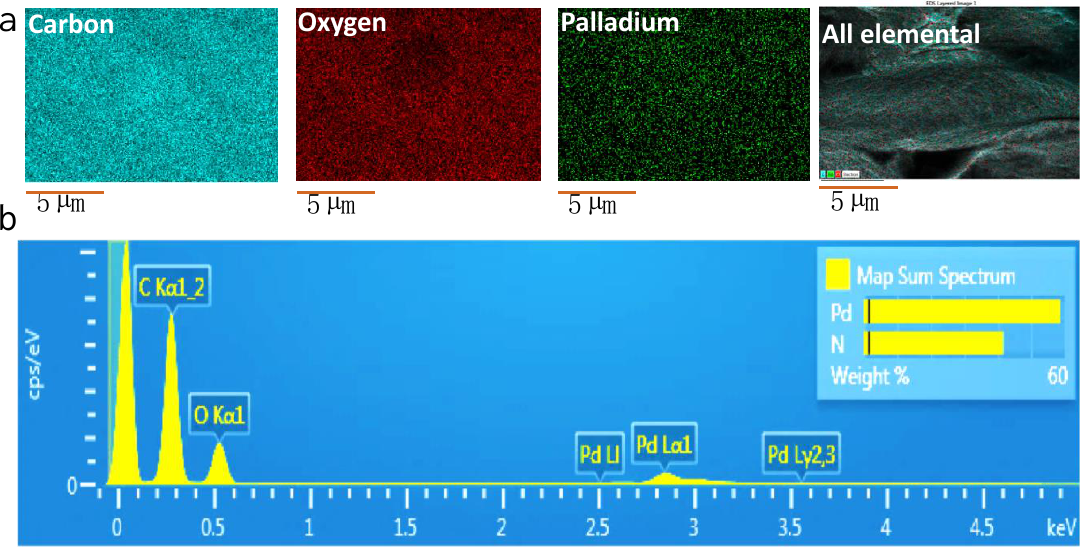
Figure 4. XPS spectra of ( a ) C 1s, ( b ) N 1s and ( c ) P 3d of MPR110-EW-P3.